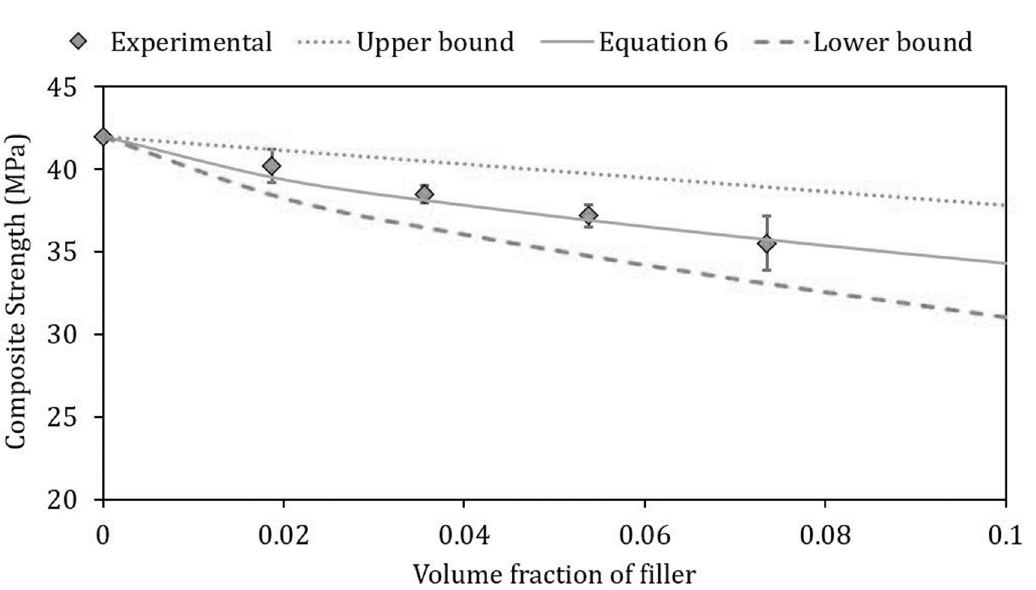
Figure 7. Comparison between the experimental strength of the PLA/PBAT biocomposites with mussel shells and the values predicted according to the different equations reported in the legend.